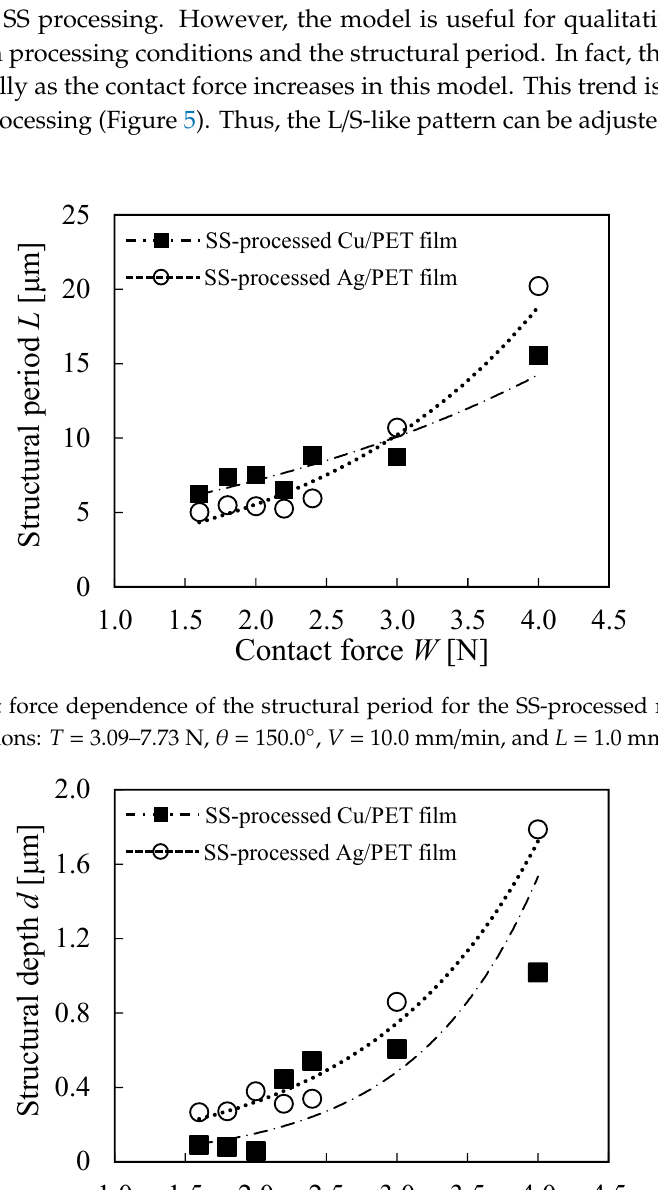
Figure 6. Contact force dependence of structural depth for the SS-processed metal/PET films. Processing conditions: T = 3.09–7.73 N, θ = 150.0°, V = 10.0 mm/min, and L = 1.0 mm.